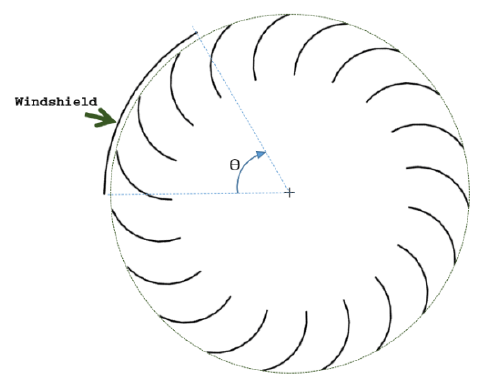
Figure 4. Windshield arc length, (cid:2016) .